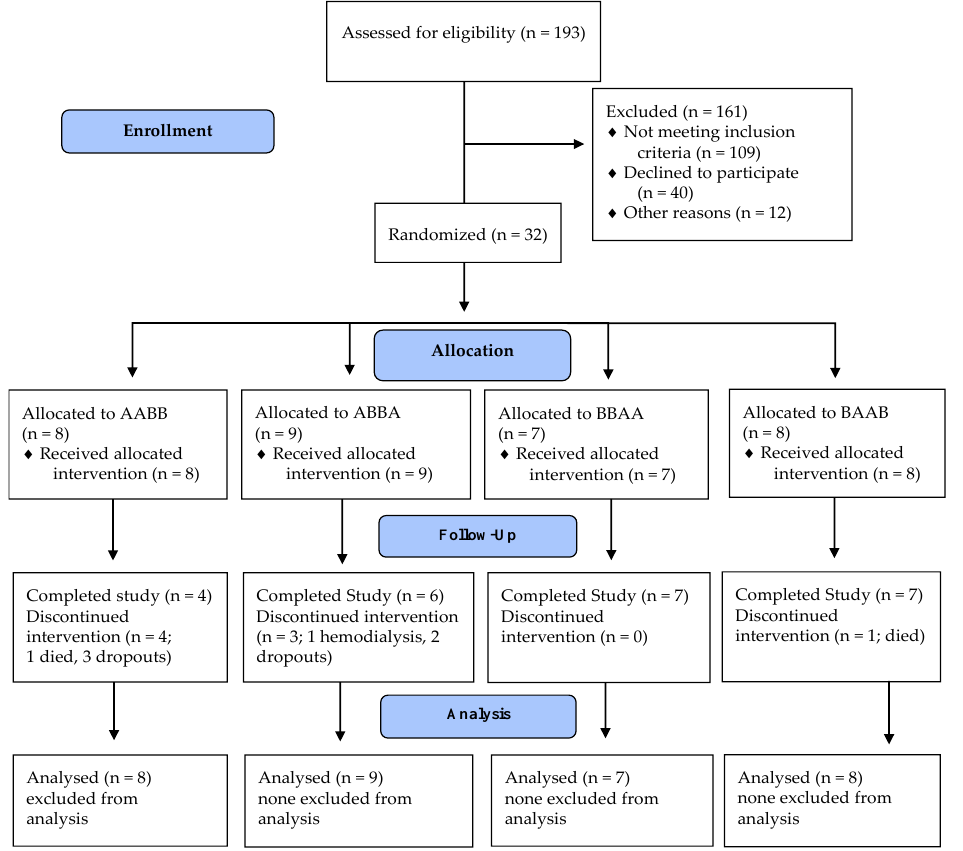
Figure 1. Study Figure 1. Study profile.